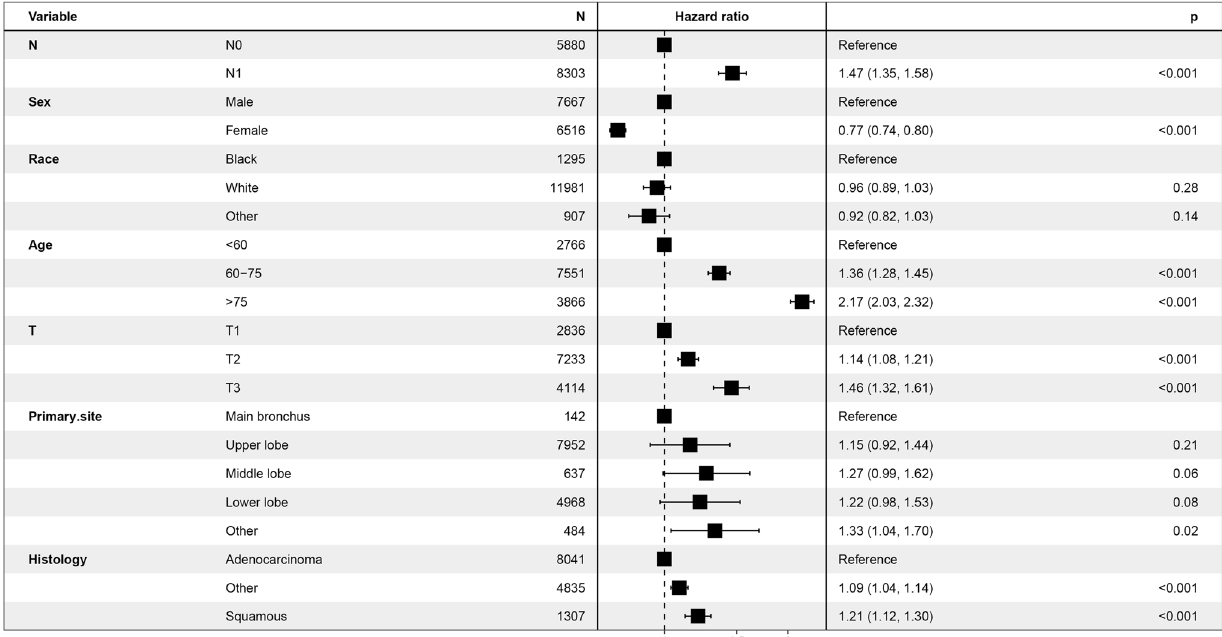
Fig. 3 Forest plot demonstrating the results of multivariate Cox regression analysis of OS predicted by pN as a